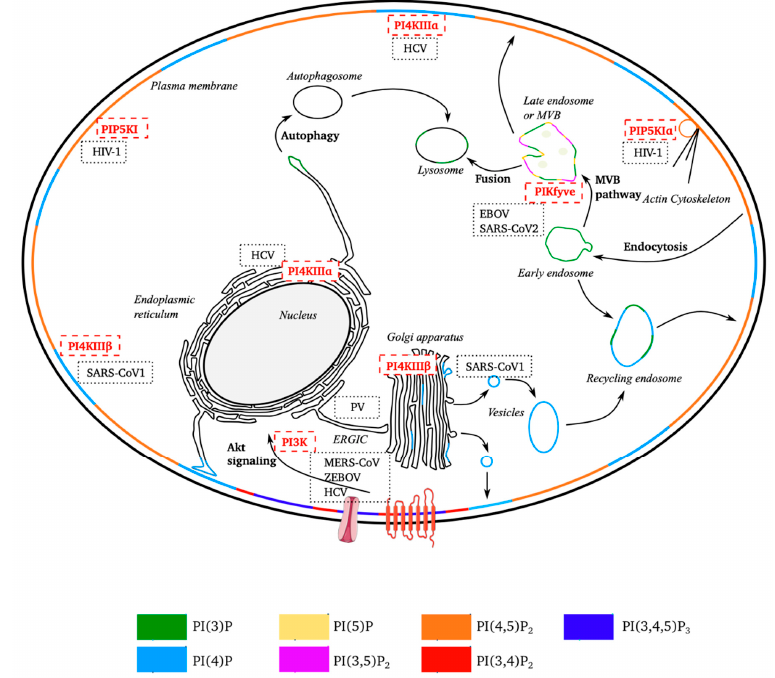
Figure 2. Schematic diagram of the subcellular distribution of phosphoinositides and sites targeted by positive-strand RNA viruses. Non-exhaustive representation of the subcellular distribution of the seven forms of phosphoinositides. Several cellular processes in which PPIns are also used are shown. The membranes of subcellular compartments are stained according to the types of PPIns predominantly present. The location of the kinases is indicated by their position, as are the sites targeted by the different RNA (+) viruses. (EBOV, Ebola virus; PV, poliovirus; SARS-CoV (1 and 2), severe acute respiratory syndrome coronavirus; MERS-CoV, Middle East respiratory syndrome-related coronavirus; HIV-1, human immunodeficiency virus; HCV, hepatitis C virus).